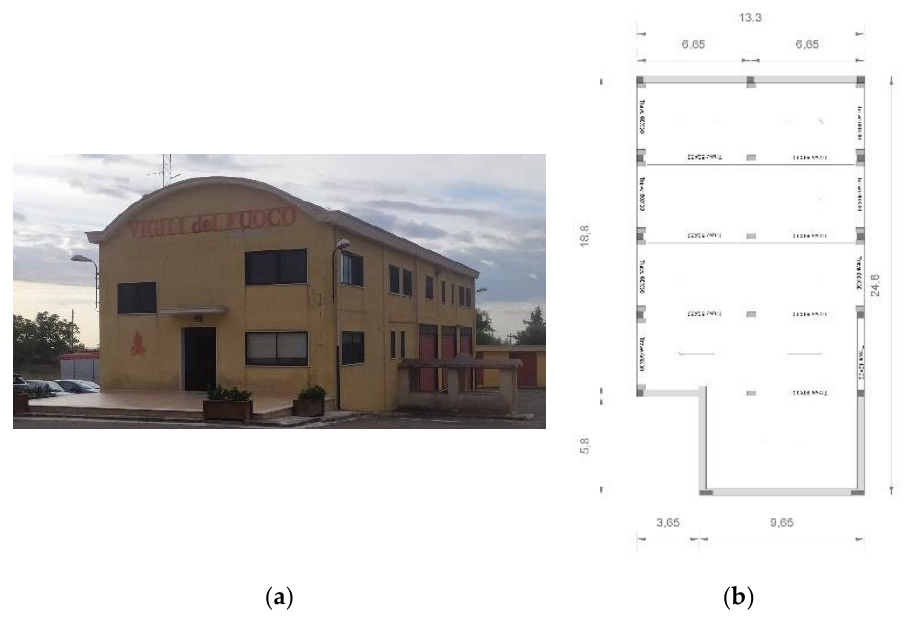
Figure 1. ( a ) Frontal view of the building; ( b ) Plant view of Structure A. Sensors 2020 , 20 , x FOR PEER REVIEW